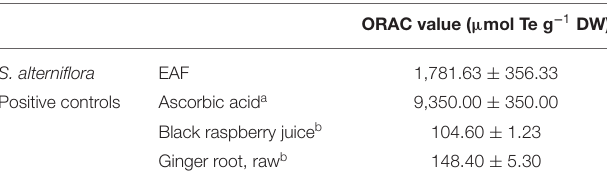
TABLE 2 | Antioxidant activity of S. alterniflora ethyl acetate fraction determined by the ORAC